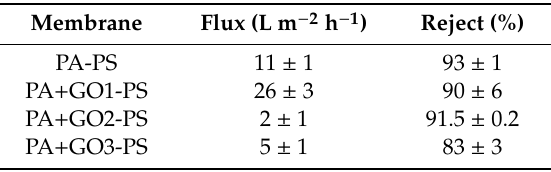
Table 7. Desalination performance of